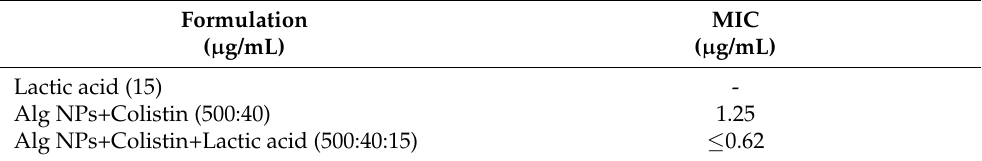
Table 3. MIC of colistin (in µ g/mL), alone and in combination with Alg NPs and lactic acid, against Escherichia coli 184 strain. Formulation